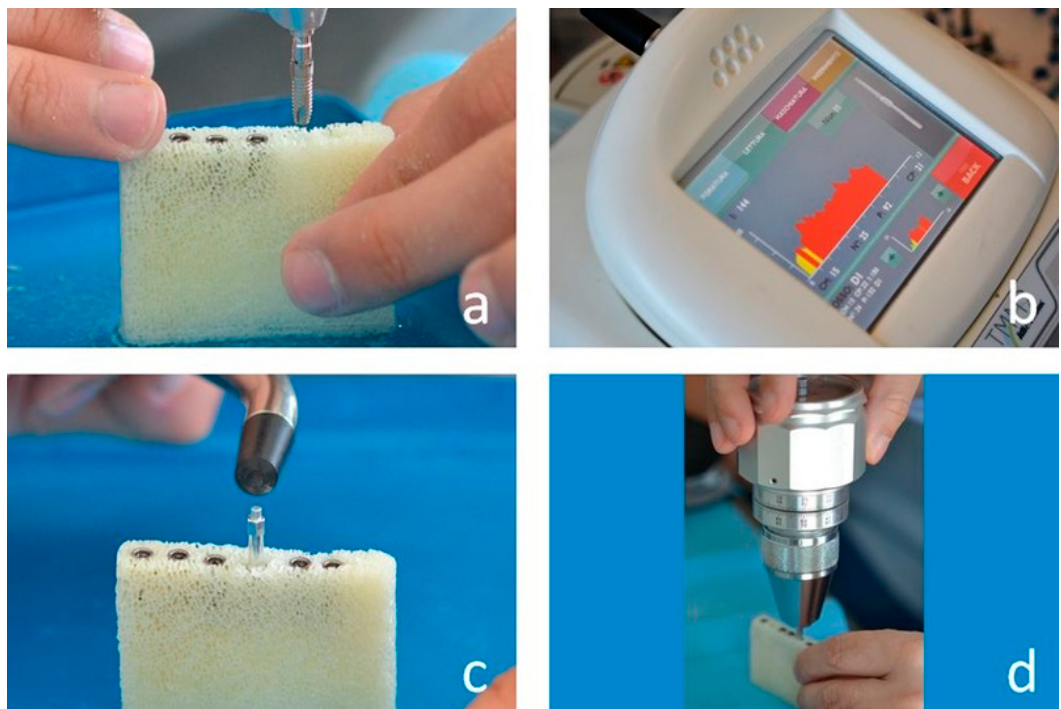
Figure 2. ( a ) One of the implants before insertion. Implants used in the present study were cylindrical 3.75 × 12 mm fixtures. While the implant is being inserted the micromotor shows again the corresponding torque–depth curve ( b ), together with the Cm, Cp (IT), I and d values. After implants